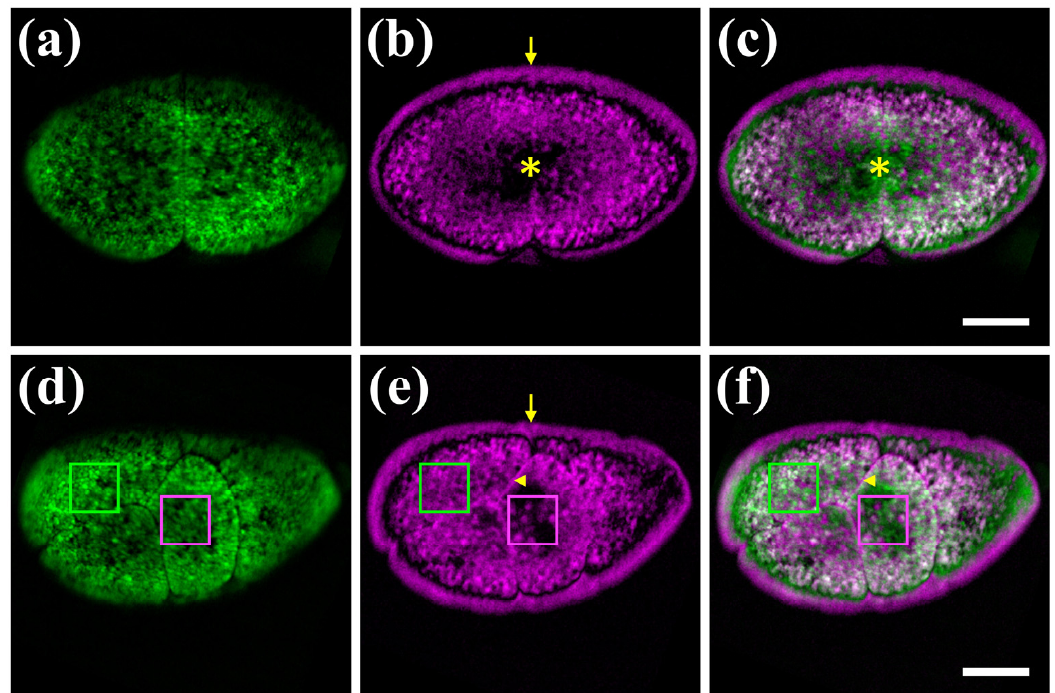
Figure 3. Hybrid imaging of unlabelled Parhyale embryos. ( a – c ) Embryo at the 2-cell stage (stage S2 according to [25]). ( d – f ) Embryo at a later cleavage stage S5. Left panels ( a , d ) show the autofluores- cence signal in green, the middle panels ( b , e ) show the PA signal in magenta, and the right panels ( c , f ) show the merged images. Asterisks indicate the yolk-free protoplasmic region, arrowheads the cell membranes, and arrows the outer eggshell mirroring the adjoining embryonic PA signal. Green and magenta boxes indicate yolk granules displaying differential autofluorescence and PA signals, respectively. Scale bars are 100 μ m.